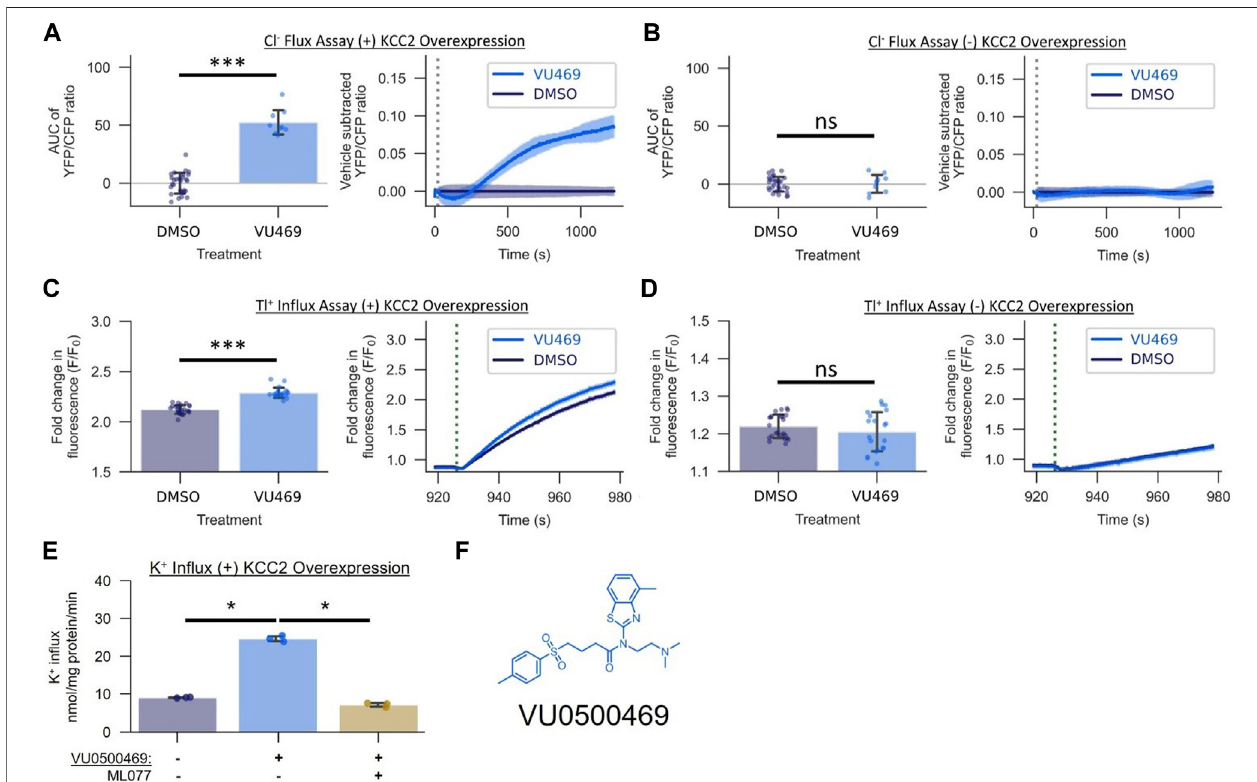
FIGURE2| VU0500469(VU469)potentiatesKCC2-mediatedCl − transportacrossmechanisticallydistinctassaysofKCC2activityinHEK-293cells. (A,B) Effectof 15 µM VU0500469 on Cl − fl ux in the presence or absence of KCC2 overexpression ( n > 9). (A) Cl − Flux Assay in cells overexpressing KCC2. Left: AUC of the YFP/CFP Cl − ef fl uxratio.Right:VehiclecontrolsubtractedandaveragedtracesoftheYFP/CFPCl − ef fl uxratio.Dottedlinerepresentstimeofcompoundaddition. (B) Cl − fl uxassay in cells lacking KCC2 overexpression. (C,D) Effect of 15 µM VU0500469 on Tl + in fl ux in the presence or absence of KCC2 overexpression ( n > 20). (C) Tl + in fl ux in cells overexpressing KCC2. Left: maximum fold increase in Tl + -sensitive dye fl uorescence. Right: fold increase in Tl + -sensitive dye fl uorescence over time. Dotted line represents time point of Tl + addition. (D) Tl + in fl ux in cells lackingKCC2 overexpression. (E) Effect of 30 µM VU0500469 on K + in fl ux in cells overexpressing KCC2 in the absence or presence of KCC2 inhibitor ML077 ( n = 3). (F) VU0500469 structure. All experiments conducted at 37 ° C. Error bars represent SD. Statistical signi fi cance calculated by Welch ’ s t-test (E) and Mann – Whitney U test (A – D) : * = p < 0.05, *** = p < 0.001, ns = p > 0.05.